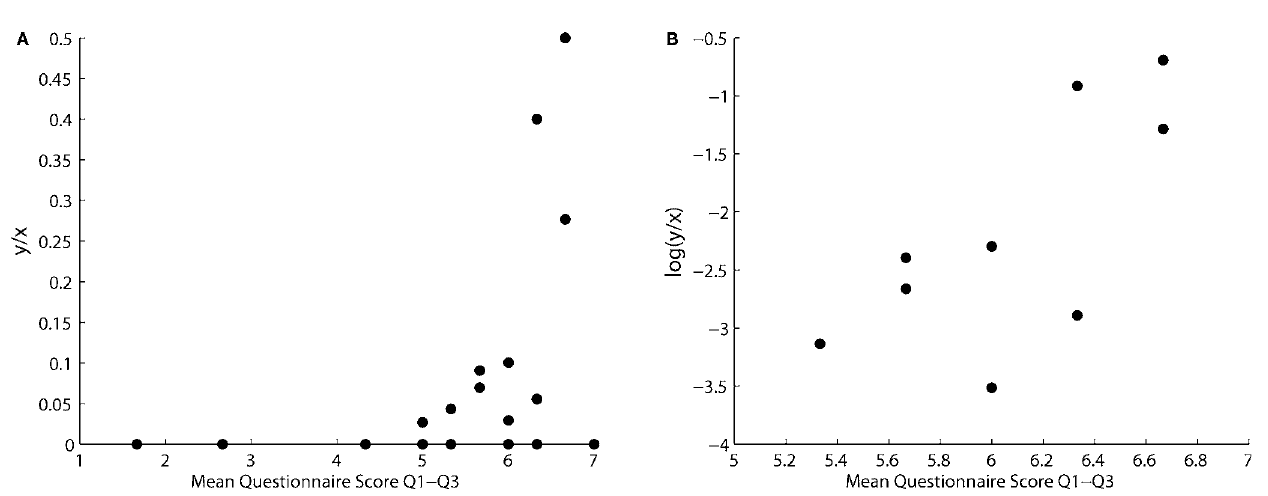
Figure 3 | Relationship between EMG activity and subjective illusion ratings. Scatterplot of y is the number of activity onsets during the fi rst t = 6 s that the virtual arm was rotating, x is the number of activity onsets in the 100 s prior to the virtual t = 6. y t / x by q over all observations, (B) log( y arm rotating. (A) y mean t